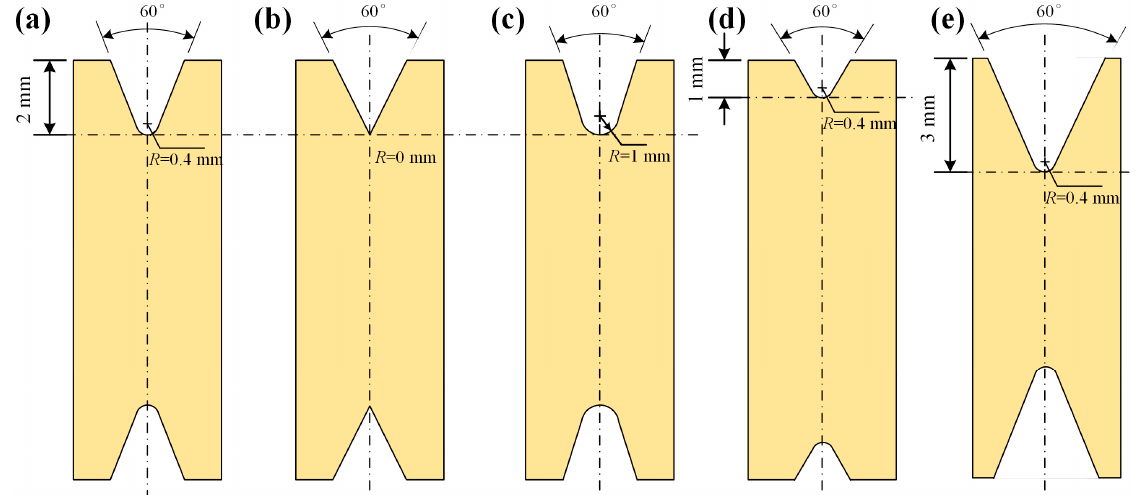
Figure 14. Geometric models of side grooves with different depth and bottom radiuses of SENB 20 specimens: ( a ) R = 0.4 mm, B - B N = 2 mm; ( b ) R = 0 mm, B - B N = 2 mm; ( c ) R = 1 mm, B - B N = 2 mm; ( d ) R = 0.4 mm, B - B N = 1 mm; ( e ) R = 0.4 mm, B - B N = 3 mm.